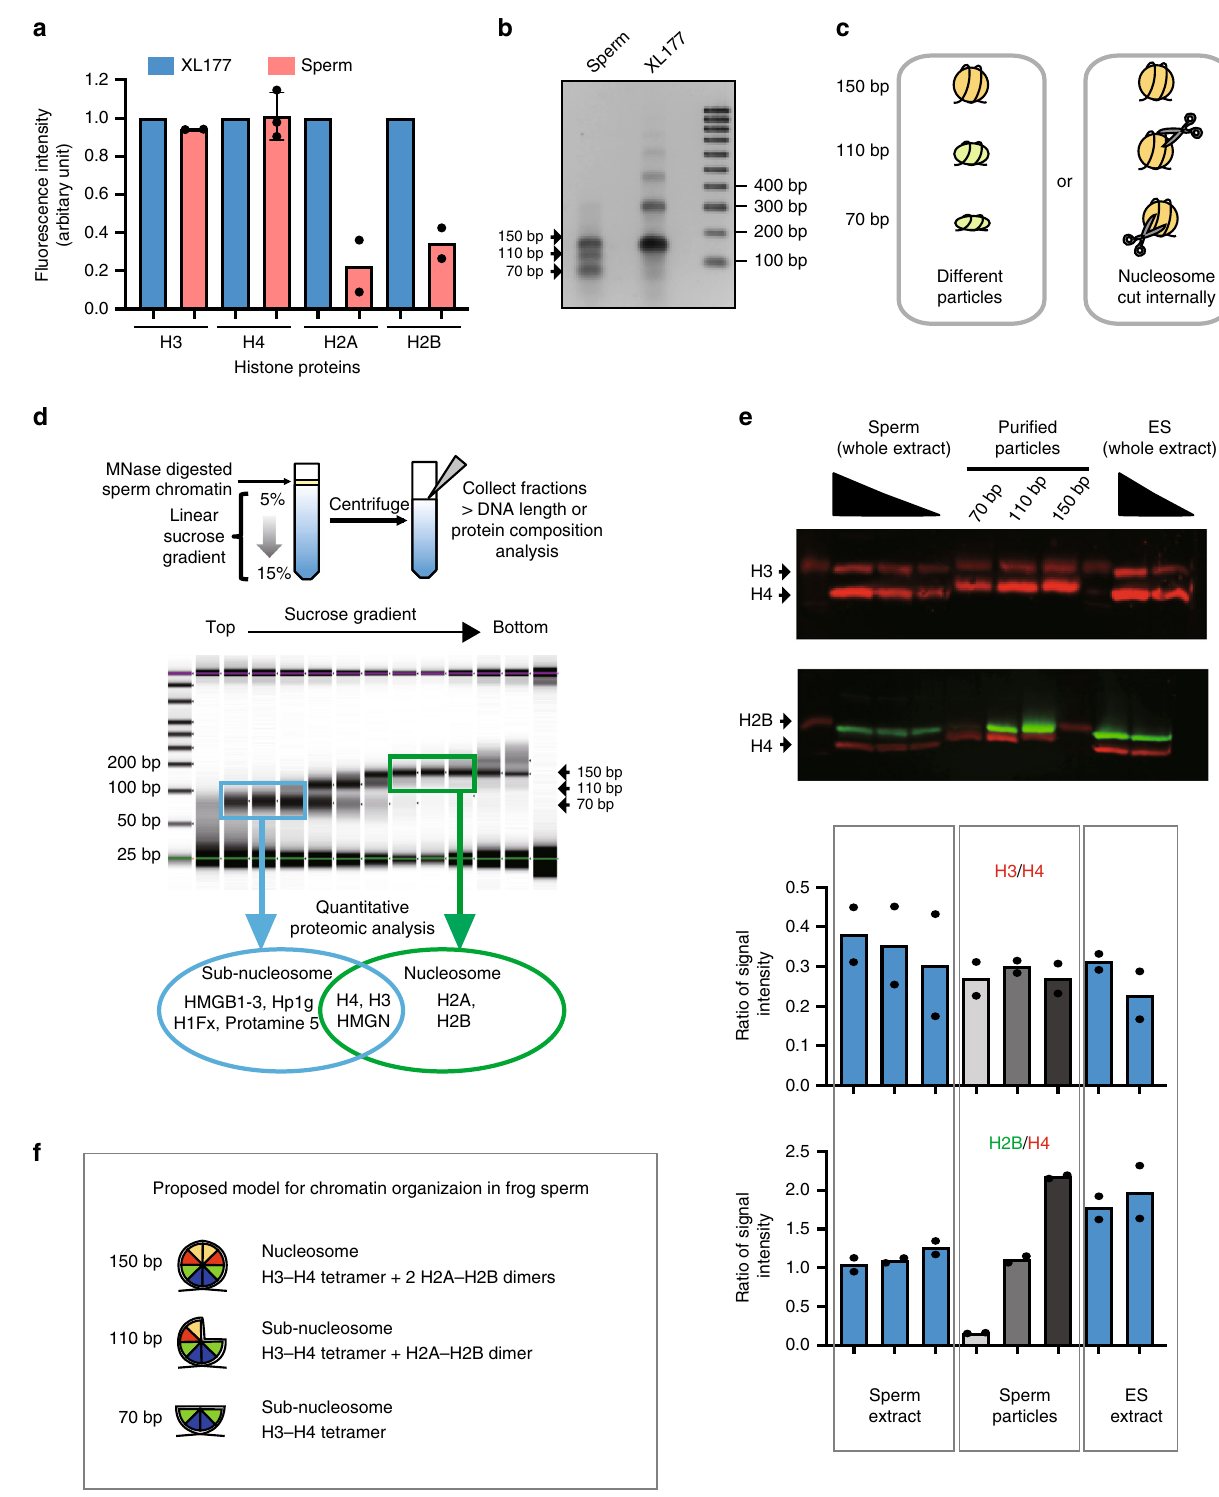
Fig. 1 Somatic level of histone H3/H4 is retained as nuclesosomes and subnucleosomes in sperm chromatin. a Xenopus laevis sperm core histones content relative to that found in a somatic cell (XL-177) as measured by quantitative WB (H2A, H2B, H3 n = 2, H4 n = 3, biologically independent samples error bar on H4 shows standard deviation). b DNA fragments generated by MNase digestion of Xenopus laevis sperm and somatic cell. c Schematic representation of the possible origin of subnucleosomal sized fragments generated by MNase treatment of sperm chromatin. d Nucleoproteic particles generated by MNase treatment of sperm are centrifugated on a sucrose gradient. Subsequently, particles isolated along the gradient are analysed for associated DNA fragment length (electrophoresis) and for associated proteins (mass spectrometry). e WB analysis con fi rms mass spectrometry analysis. Similar ratio of H3 to H4, and decreased level H2B to H4 are detected in subnucleosomes compared with nucleosomes. Xenopus sperm and mESCs are shown as control. Graphs below show the quanti fi cation of WB data ( n = 2, biologically independent samples). f Model of core histone composition of Xenopus laevis sperm nucleosomal and subnucleosomal particle. Source data related to a , b , d and e are provided as Source Data fi